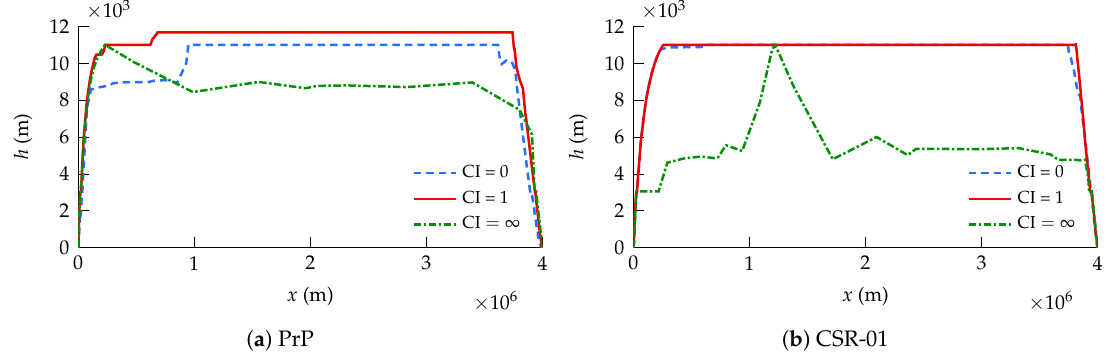
Figure 7. Design mission profile for the ( a ) PrP and ( b ) CSR-01, for different CIs.